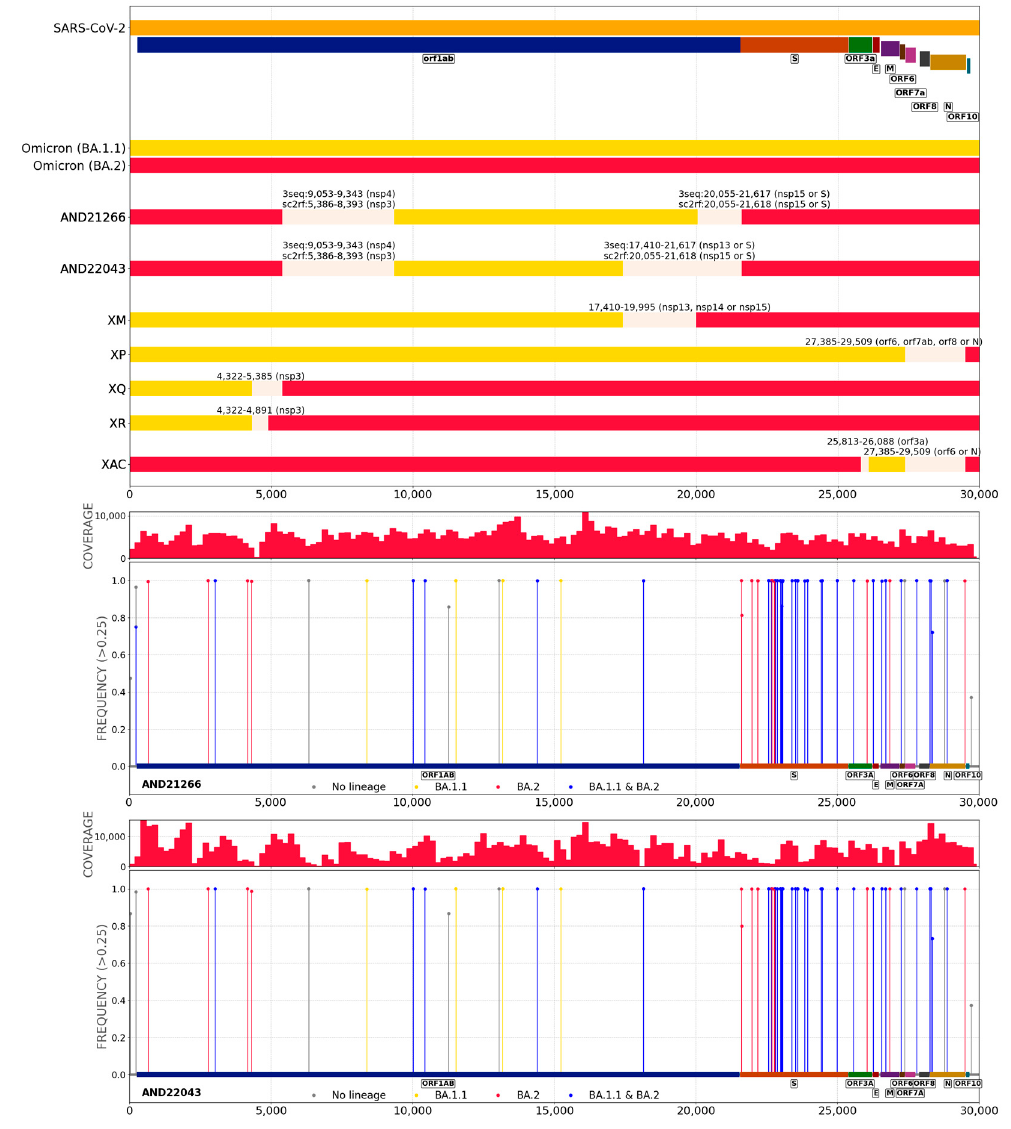
Figure 5. Novel omicron-omicron recombinants corresponding to two different, unrelated samples: AND21266 and AND22043 (see Tables S1 and S3). 3seq outputs for BA.2 and BA1.1 lineages and their corresponding breakpoints, sc2rf outputs BA.2 and BA.1 lineages with similar breakpoints to 3seq ones. A breakpoint interval (grey bar) spans between the lowest and the greatest position value of breakpoints provided by the two recombinant detection tools. Plots of distribution of mutations is also shown for AND21266 sample.